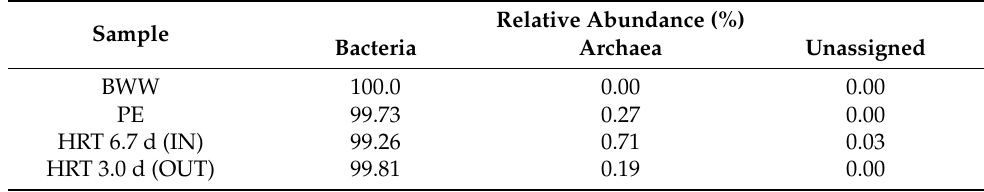
Table 6. Relative abundance of the Bacteria and Archaea